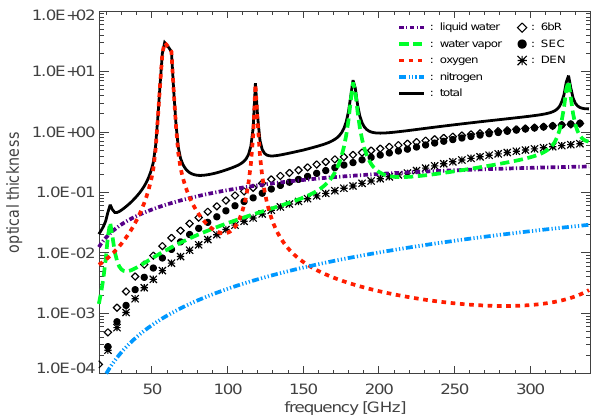
Figure 1. Optical thickness vs. frequency for an atmosphere with typical winter conditions at the Zugspitze site (2960m altitude) including a single-layer cloud with homogeneously distributed LWP=0.1kgm − 2 and SWP=0.2kgm − 2 . Different snow habits have been considered classified according to Liu (2008a): six-bullet rosettes (6bR), sector snowflake (SEC), dendrite snowflake (DEN).